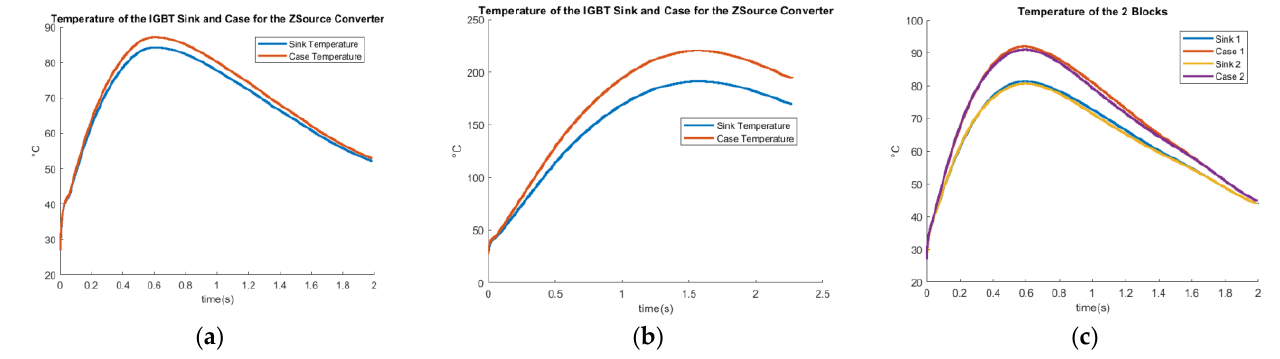
Figure 24. Sink and case temperatures for ( a ) one IGBT module in the two paralleled ST IGBT module